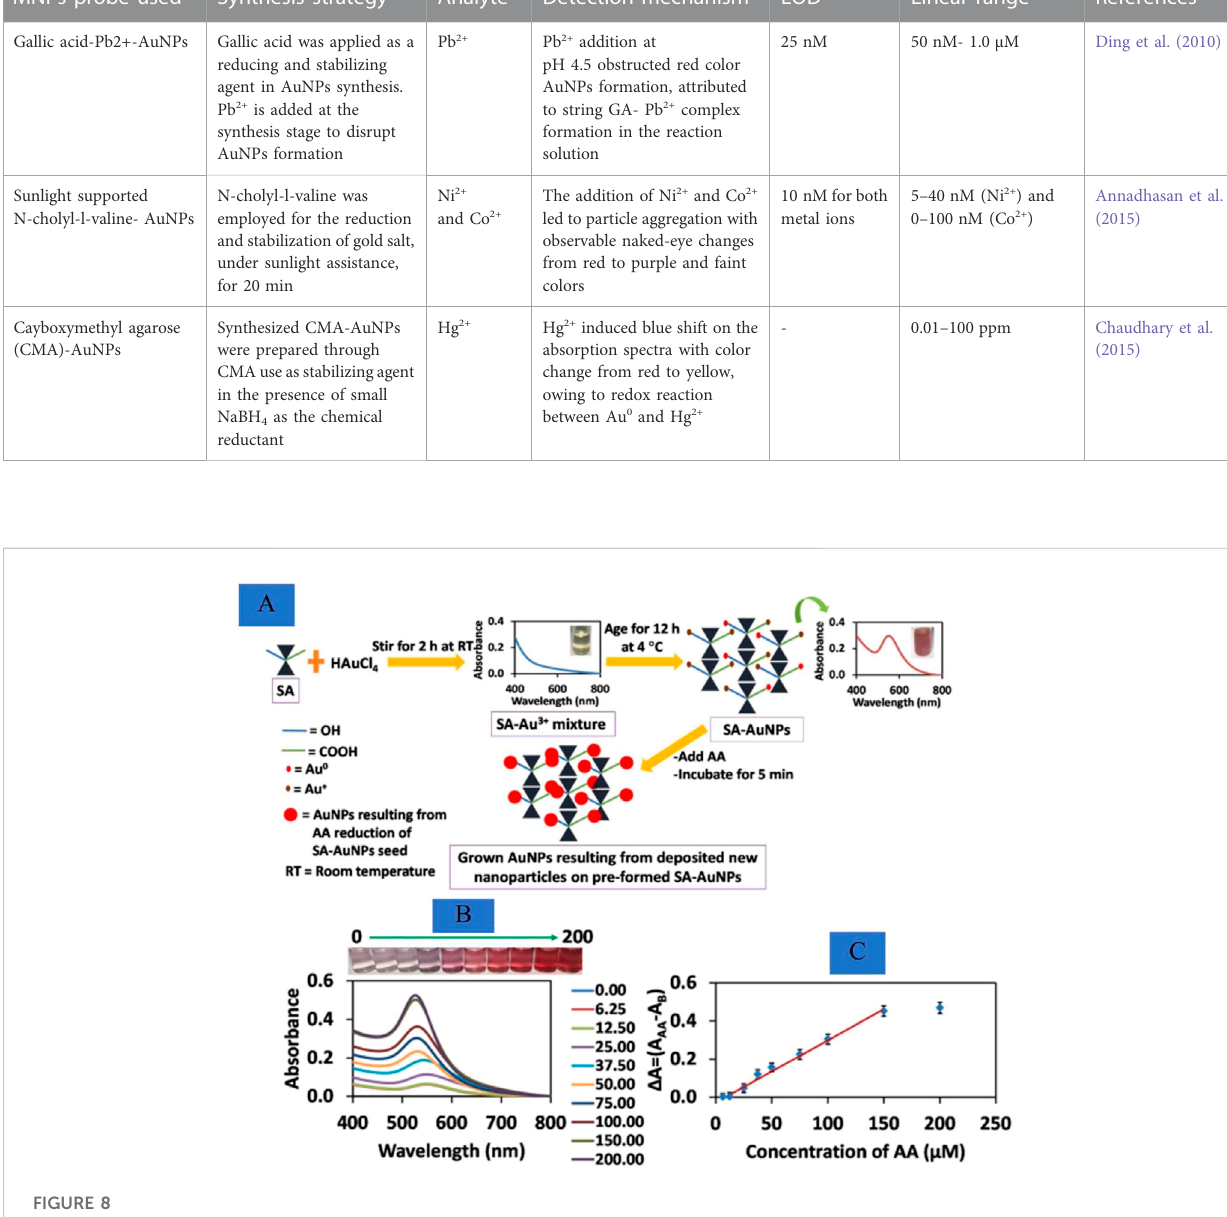
FIGURE 8 (A) Depiction of synthesis protocol of sodium reduced and stabilized AuNPs probe (SA-AuNPs), and its AA detection strategy (B) Photo images and absorption spectra enhancement after AA injection and (C) Linear range of the sensor within 12.5 – 150.0 µM. Reproduced with permission from Jayeoye et al. (2021b). Copyright 2021,